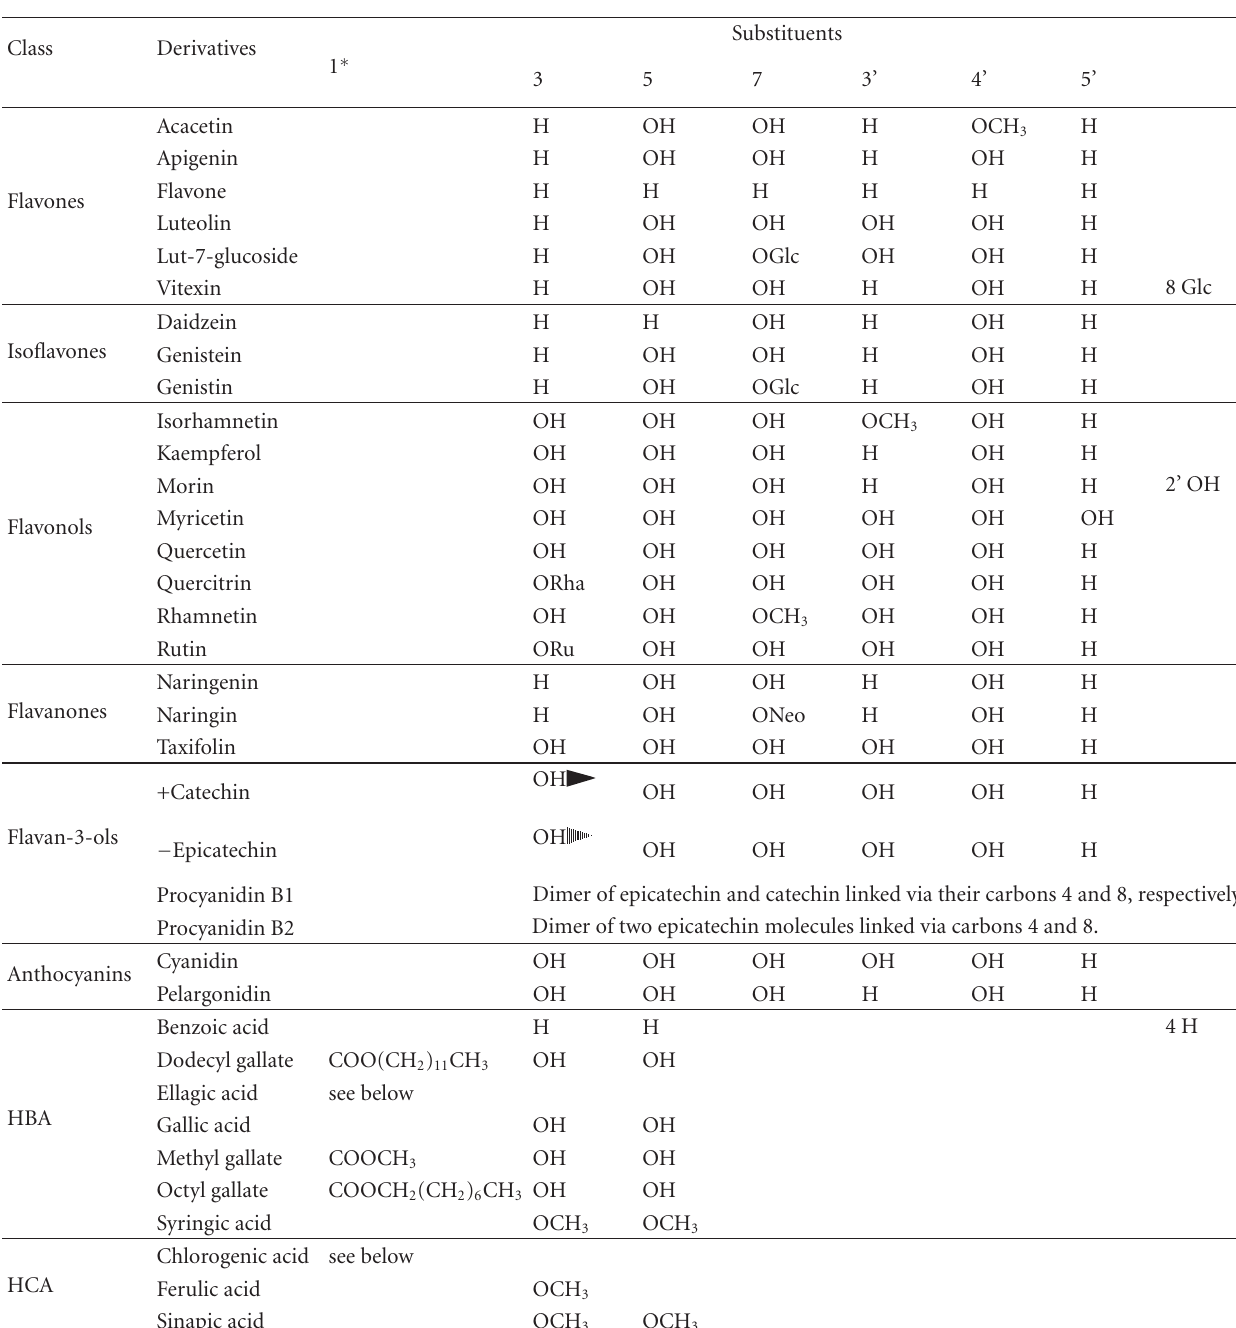
Table 1: Chemical structures of the phenolic compounds used in the present